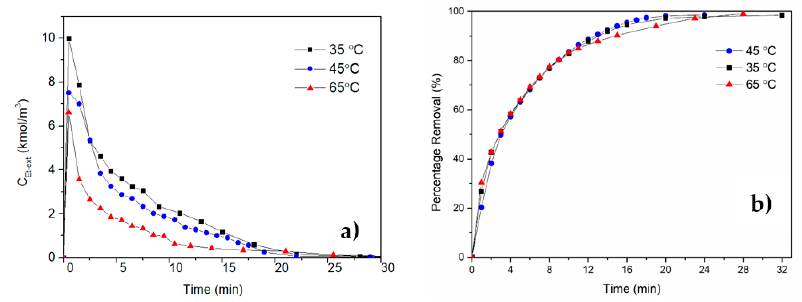
Figure 20. Ethanol exit concentration change ( a ) and percent removal ( b ) with time for different temperatures for supercritical drying of calcium alginate beads.